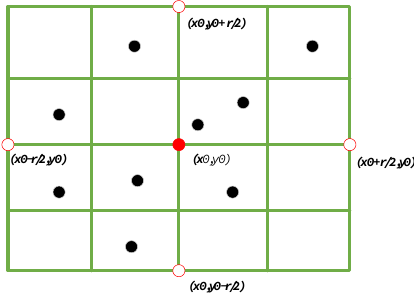
Figure 5. Schematic diagram of point density calculation.